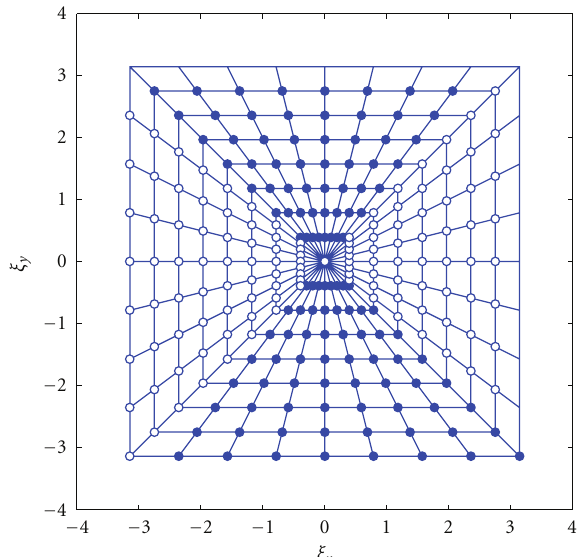
Figure 2: Basically vertical subnet (filled circles) and basically horizontal subnet (hollow circles) comprising the pseudo-Polar grid formed by the intersection of 8 concentric squares and 16 slope- equispaced rays. (This figure first appeared in